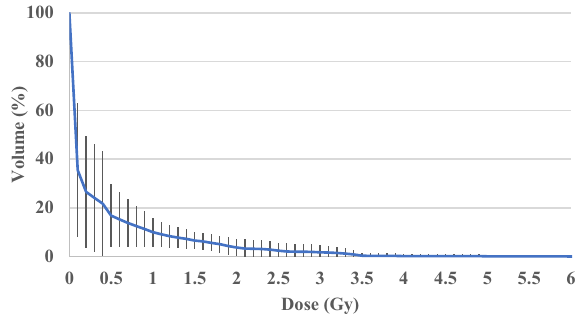
Figure 1. The average planned cumulative body dose volume histograms (solid line) for the whole population. Error bars represent standard deviation of the percentage volume of body receiving a dose equal or greater than or equal to that dose bin (a given range of dose e.g. 0–0.1